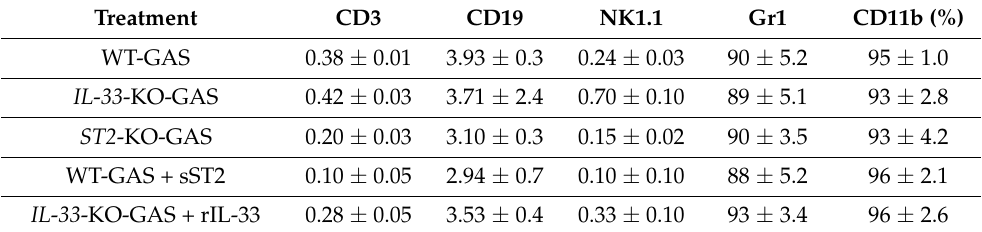
Table 2. Analysis of cell populations of infiltrating cells in the air pouches of mice after GAS infection. Treatment CD3 CD19 NK1.1 Gr1 CD11b (%) WT-GAS 0.38 ± 0.01 3.93 ± 0.3 0.24 ± 0.03 90 ± 5.2 95 ± 1.0 IL - 33 -KO-GAS 0.42 ± 0.03 3.71 ± 2.4 0.70 ± 0.10 89 ± 5.1 93 ± 2.8 ST2 -KO-GAS 0.20 ± 0.03 3.10 ± 0.3 0.15 ± 0.02 90 ± 3.5 93 ± 4.2 WT-GAS + sST2 0.10 ± 0.05 2.94 ± 0.7 0.10 ± 0.10 88 ± 5.2 96 ± 2.1 IL - 33 -KO-GAS + rIL-33 0.28 ± 0.05 3.53 ± 0.4 0.33 ± 0.10 93 ± 3.4 96 ±